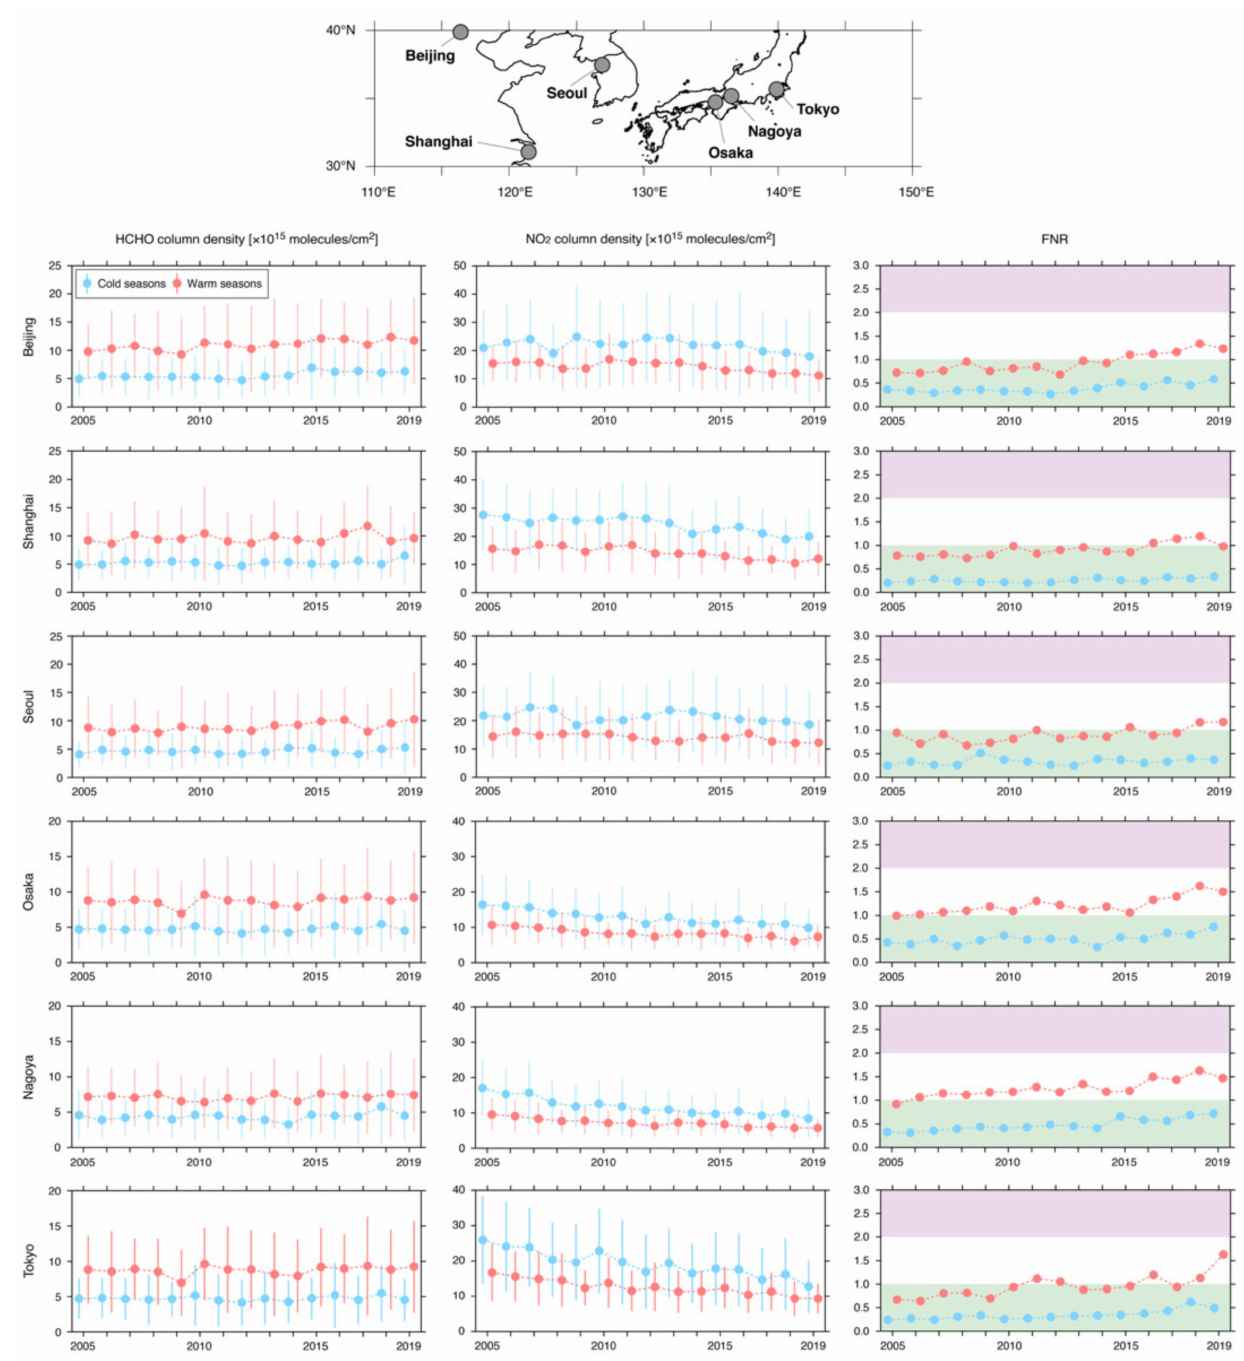
Figure 4. Temporal variation of HCHO column density, NO 2 column density, and FNR during 2005–2019 over Beijing and Shanghai in China, Seoul in the Republic of Korea, and Osaka, Nagoya, and Tokyo in Japan averaged over cold seasons (light blue symbols) and warm seasons (light red symbols) for each year. The green, white, and purple shading in the FNR panels indicates VOC- sensitive, transitional, and NO x -sensitive regimes,